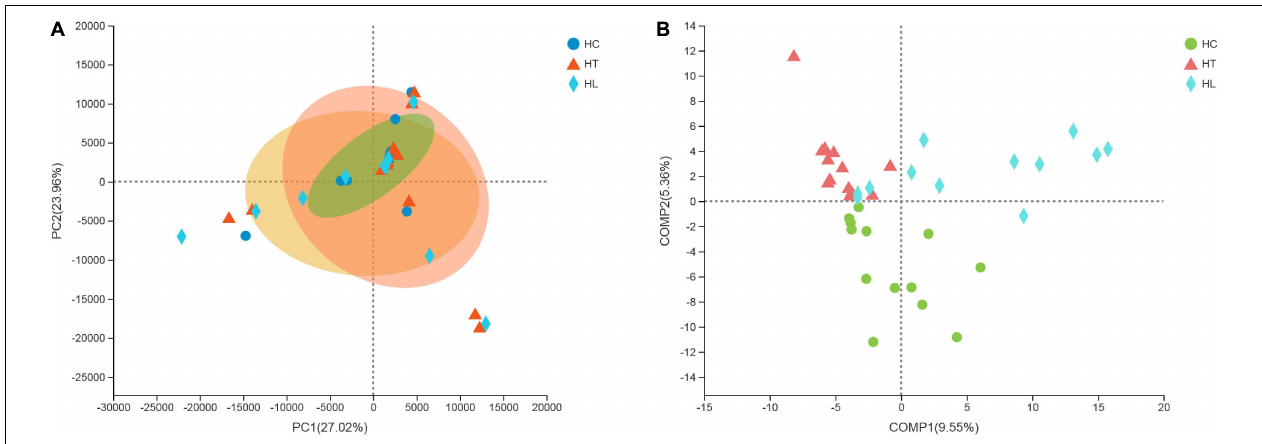
FIGURE 2 | Principal coordinate analysis (PCoA) plot (A) and the supervised discriminant analysis with Partial Least Squares Discriminant Analysis (PLS-DA) plot (B) based on QIIME software between intestinal microbiota samples from HC, HT, and HL groups. HC: The control group, HT: The L. lactis 1,209 treatment group, HL: The L. lactis 1,242 treatment